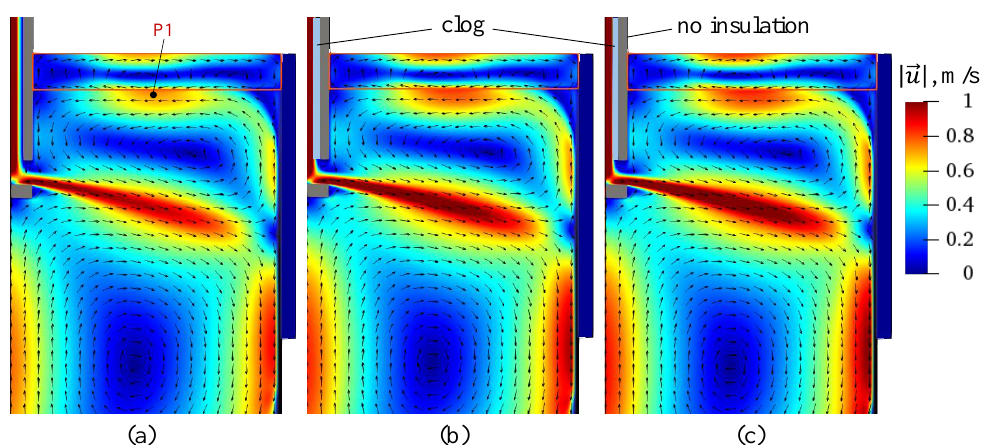
Figure 8. Simulation results for the mold flow: ( a ) initial setup with the fiber insulation of the SEN; ( b ) formation of the 12 mm clog layer; and ( c ) uninsulated SEN with the solidified layer overgrowing the clog (see Figure 7c).